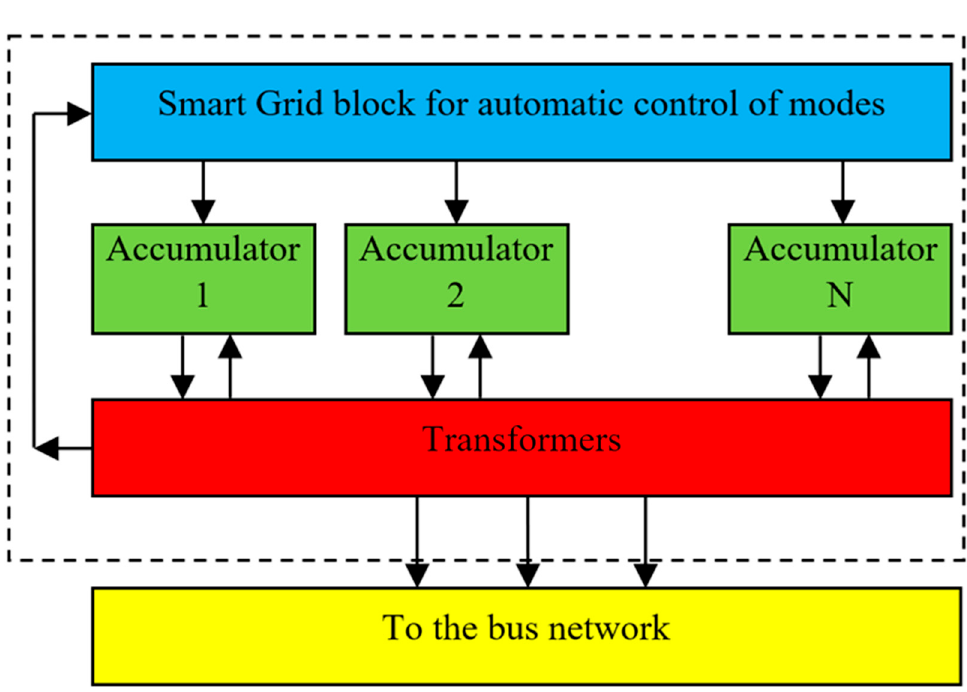
Figure 2. Structural diagram of Smart Grid with electricity storage